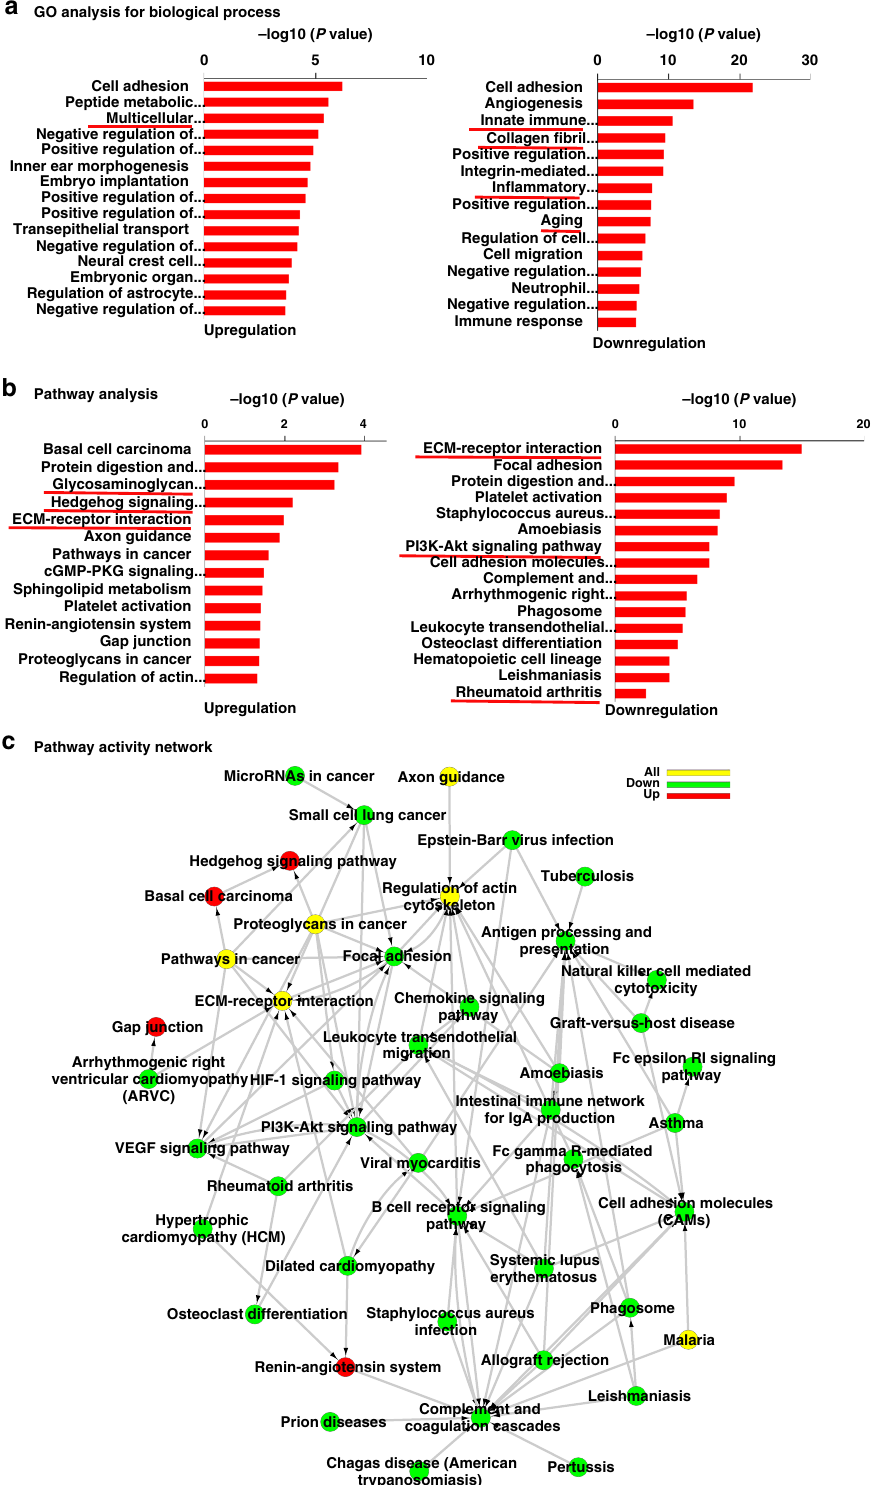
Fig. 5 Cartilage transcriptome determined by RNA sequencing. a Gene ontology (GO) analysis for differentially expressed genes of cartilage transcriptome in rat anterior cruciate ligament transection (ACLT) model treated with BNTA or vehicle for 4 w. b Pathway analysis for differentially expressed genes from the rat cartilage transcriptome. c Pathway activity network construction using pathway terms ( P <